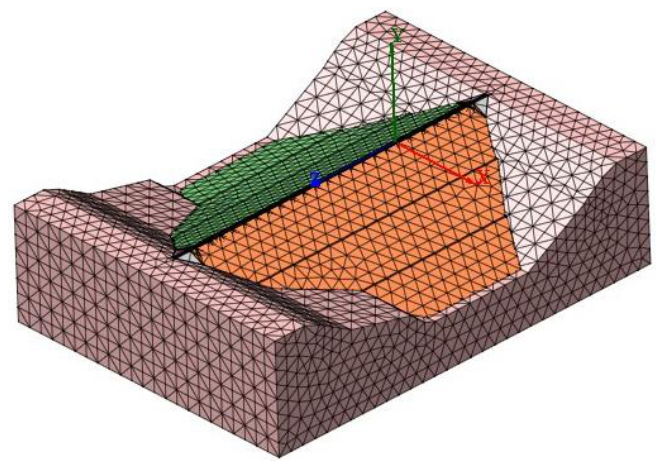
Figure 7. 3D finite element model of dam.